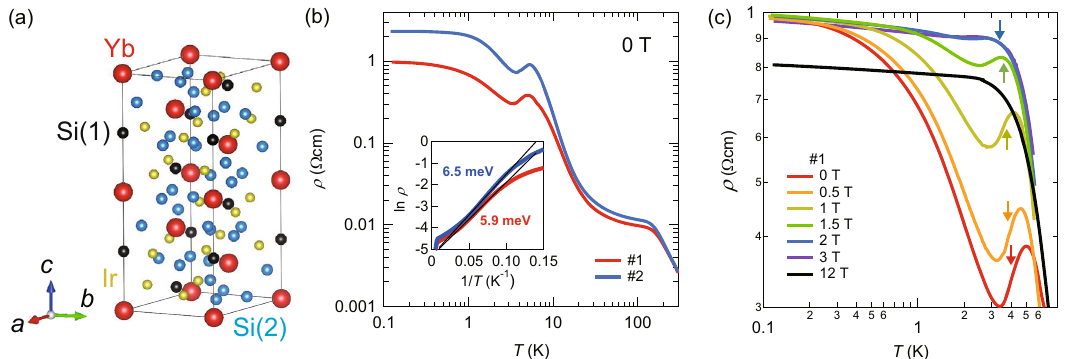
Fig. 1 Crystal structure and transport properties of YbIr 3 Si 7 . a Crystal structure of YbIr 3 Si 7 . There are two crystallographically inequivalent Si sites, Si(1) and Si(2). b Temperature dependence of the in-plane resistivity ρ for #1 and #2 single crystals. The inset shows the Arrhenius plot of ln( ρ ) vs. 1/ T . The solid lines represent the thermally activated behaviors with charge gaps of 5.9 and 6.5 meV for #1 and #2 single crystals, respectively. c Low temperature resistivity of #1 crystal in magnetic fi elds applied perpendicular to the ab plane. The arrows indicate the Néel temperature determined by the speci fi c heat.